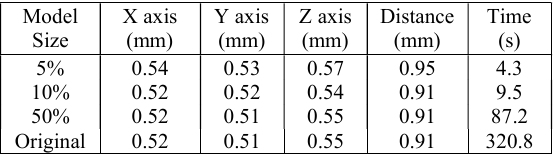
Table 1. 3D reconstruction errors (RMS) averaged over 35 consecutive poses for the tibia.